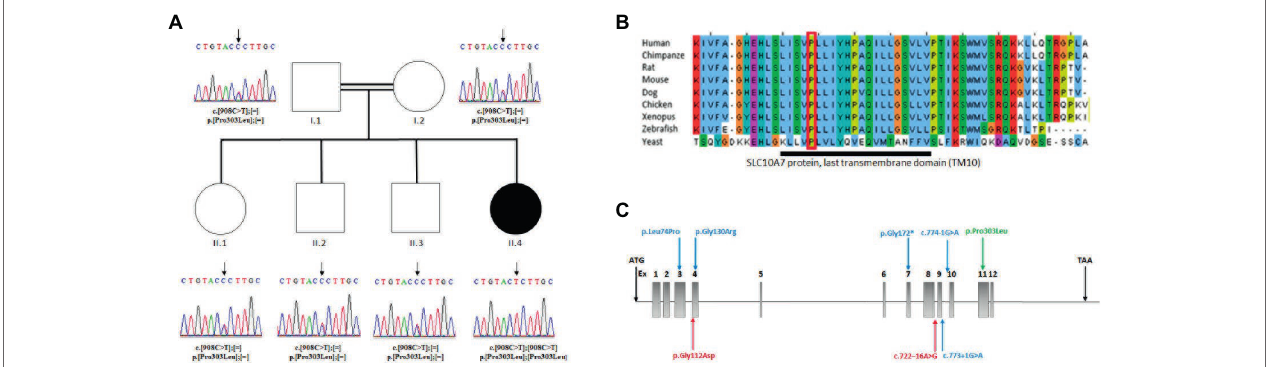
FIGURE 2 | (A) Analysis of the SLC10A7 mutation: Pedigree of the AI patient and DNA sequencing chromatograms of the whole family. Parents and other children were heterozygous and the patient was homozygous for the mutation. An arrow points to the mutation. (B) Multiple sequence alignment of SLC10A7 last transmembrane domain (TM10). The largely conserved sequence of the proteins last transmembrane domain is represented by the dark bar. The amino-acid affected by the missense mutation in the patient (red square) is conserved from human to yeast. (C) Human SLC10A7 mutations in the literature. The SLC10A7 gene contains 12 exons. The mutations described in Dubail et al. (2018) are represented by blue arrows and those reported in Ashikov et al., 2018 by red arrows. Our mutation is the only mutation located at the end of the gene (exon 11) and is represented by a green arrow.